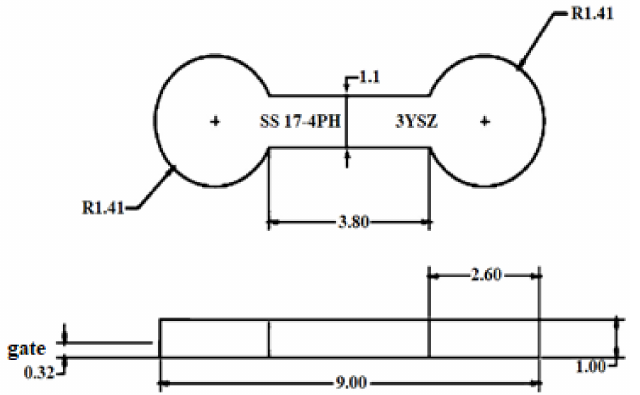
Figure 3. Schematic of the 17-4PH/zirconia micro-sized component (all dimensions are in mm), reused with permission from Elsevier